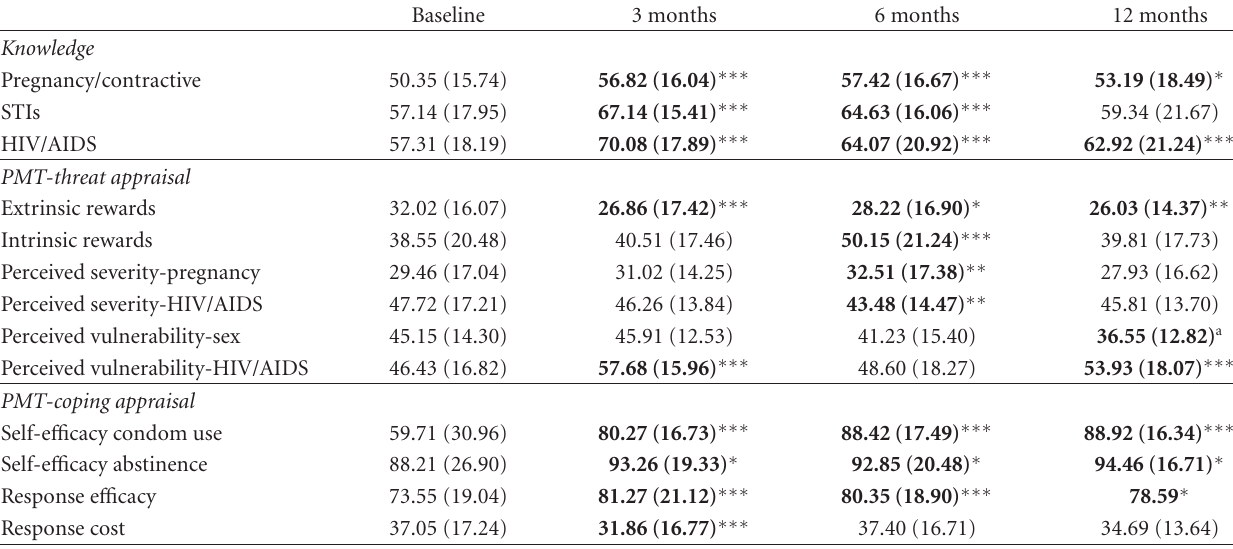
Table 4: Standard mean scores (with standard deviation) (range 0–100) for knowledge and PMT constructions at baseline and follow-ups for EWA+ a .